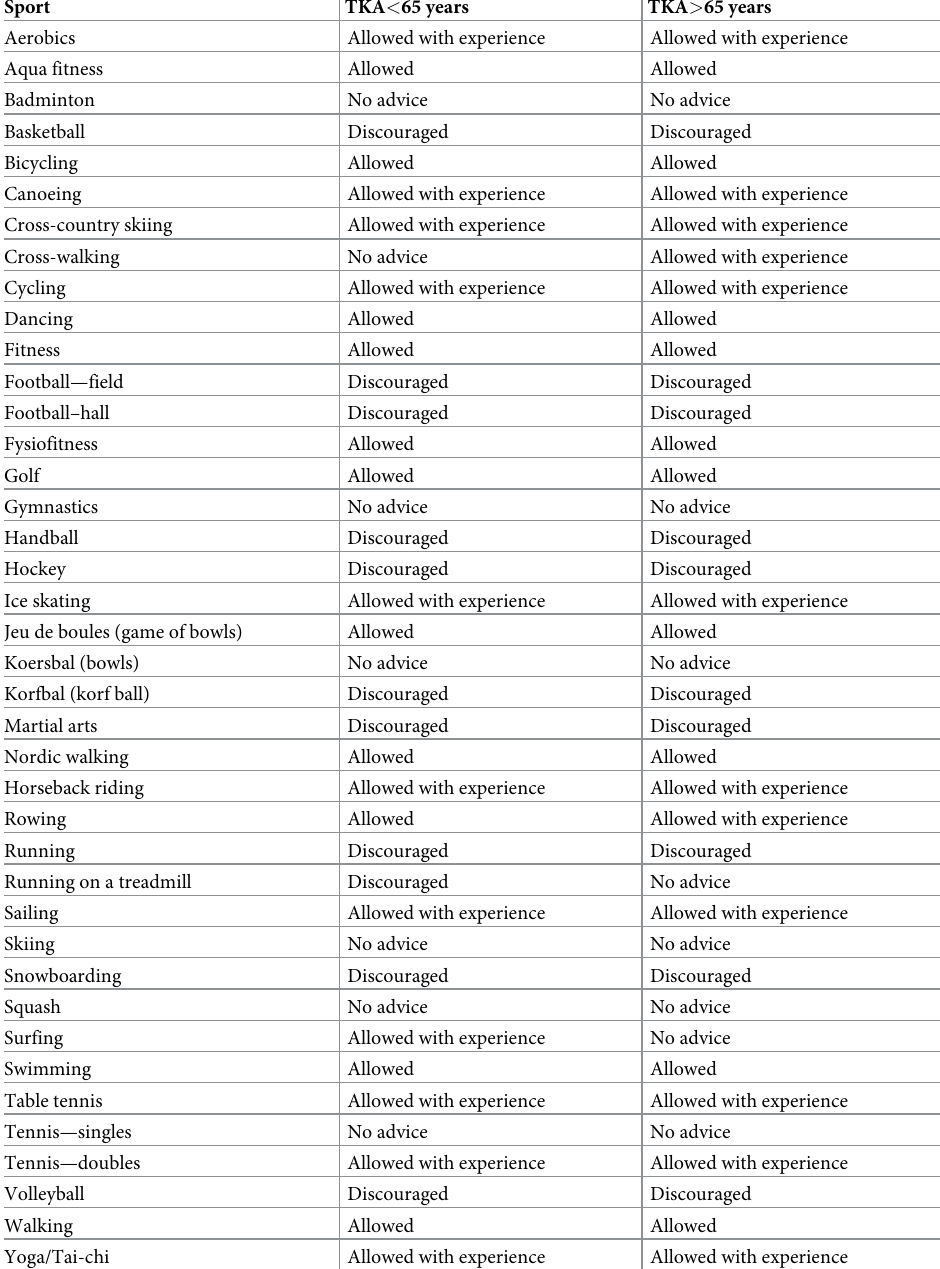
Table 2. Sport advice after TKA. Sport